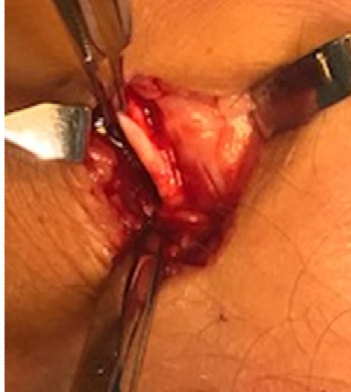
Figure 2. Surgery of a patient with midportion Achilles and plantaris tendinopathy. There is a thick and wide plantaris tendon located close to the medial side of a thickened Achilles